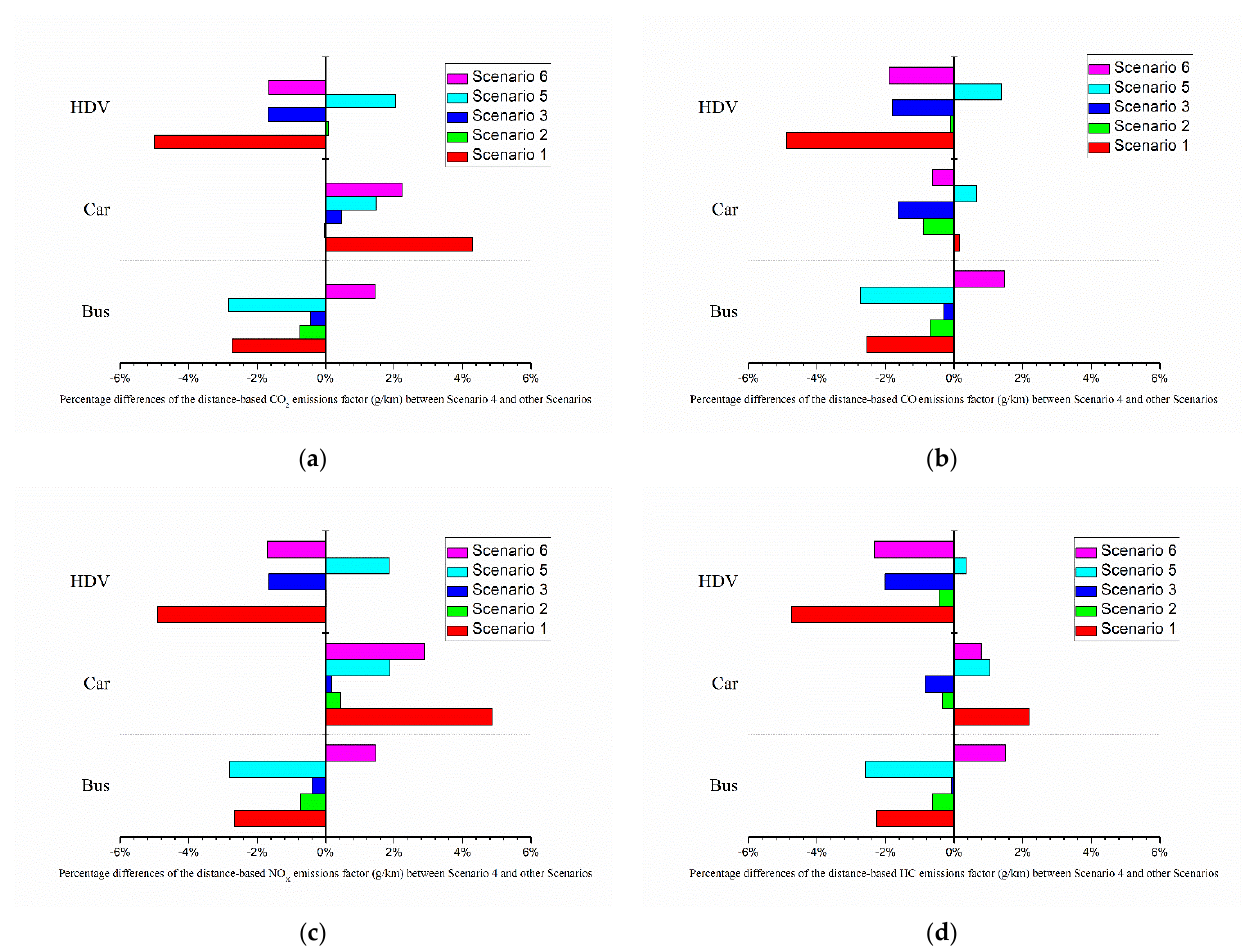
Figure 7. Percentage differences of emission factors in different scenarios compared to base case: ( a ) CO 2 , ( b ) CO, ( c ) NO X , and ( d ) HC.